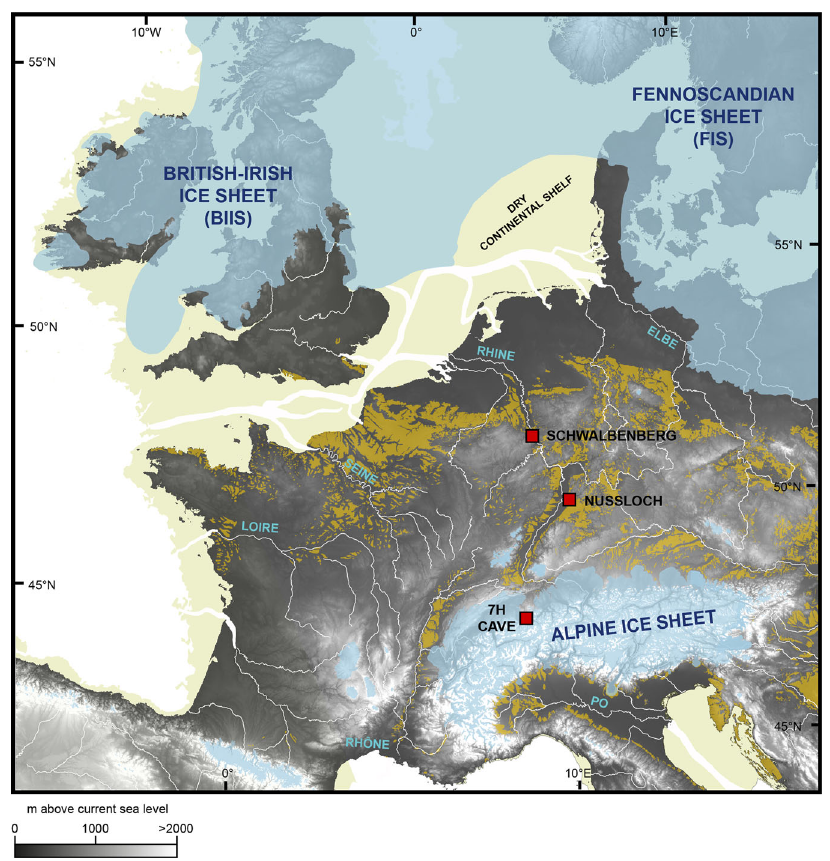
Fig. 1 DEM-based map showing the Palaeogeography of western and central Europe during the Last Glacial Maximum (LGM ~21 ka). The distance between Schwalbenberg (50.56°N; 7.24°E) and Nussloch (49.18°N; 8.70°E) loess sites is ~180 km. Yellow patches represented areas of loess and loess derivates 26,28 . Beige-coloured areas represent the dry continental shelves 28 . The DEM is based on combined DEMs 26 of the GLOBE Project (1 km resolution